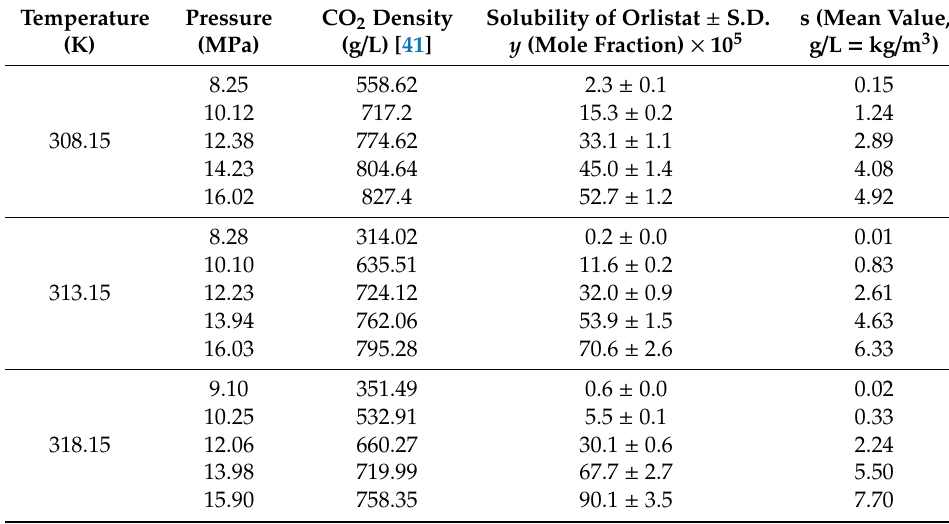
Table 1. Solubilities of orlistat in SC-CO 2 ( n =